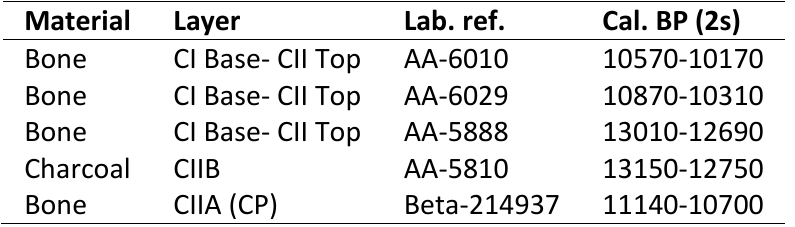
Table 1. Radiocarbon dates from the Picamoixons